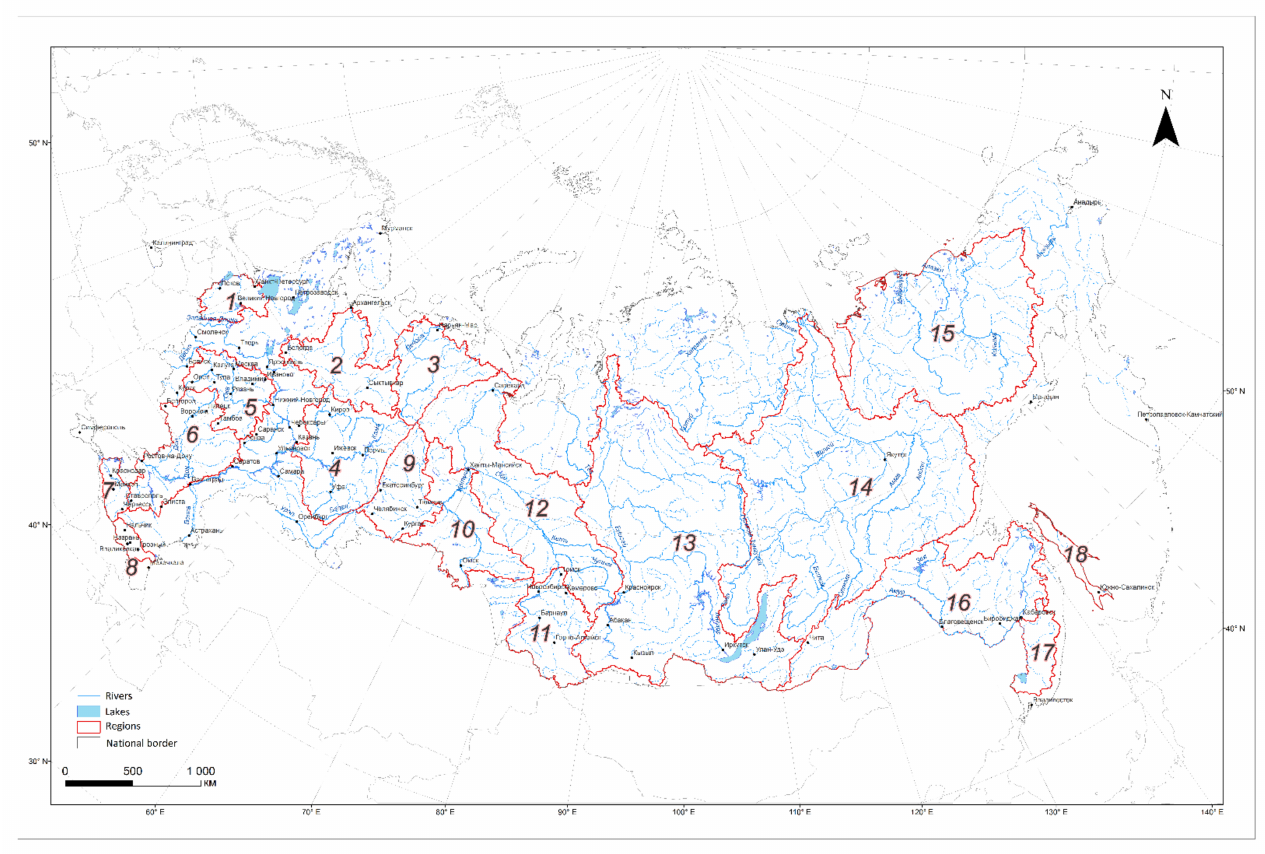
Figure 4. Regions with a single relationship of the predictability indicator of river flow and the function of morphometric characteristics of the catchment